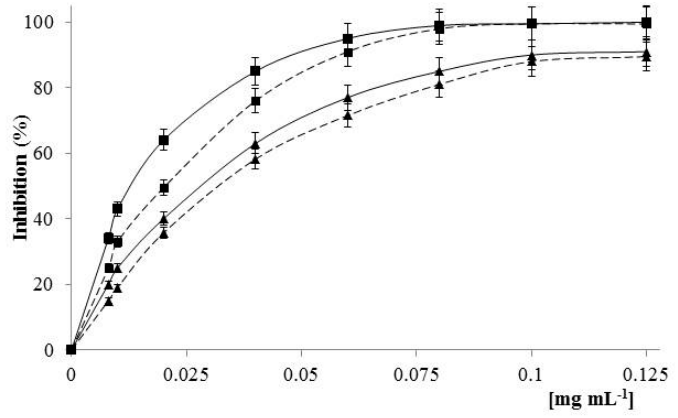
Figure 5. Scavenging activity of LDC3 (- - - -) against ABTS ( ∎ ) and DPPH ( ▲ ) radicals. Ascorbic acid (w/v) ( _____ ) was used as positive